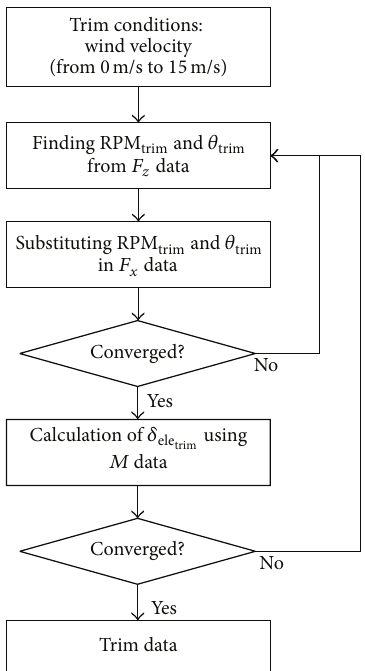
Figure 8: Trim calculation